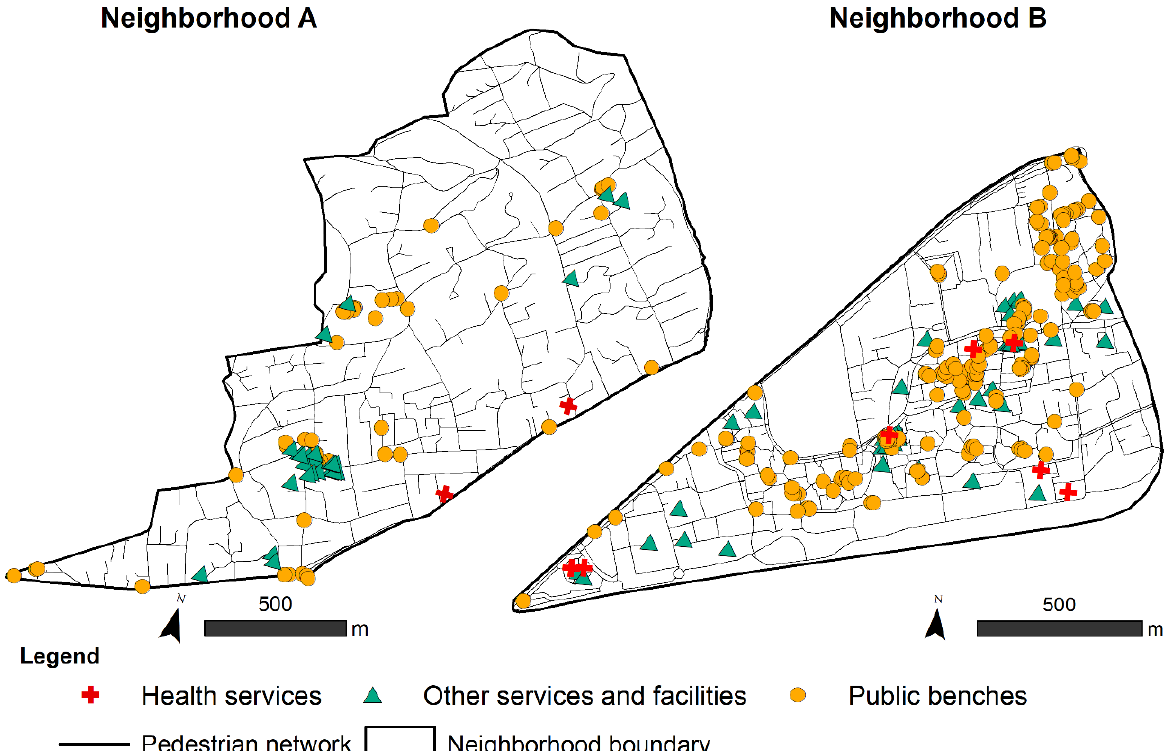
Figure 2. Analysis variables for calculating accessibility by neighborhood. Maps created by the authors with ArcGIS 10.4. Table 1. Neighborhood services and facilities.